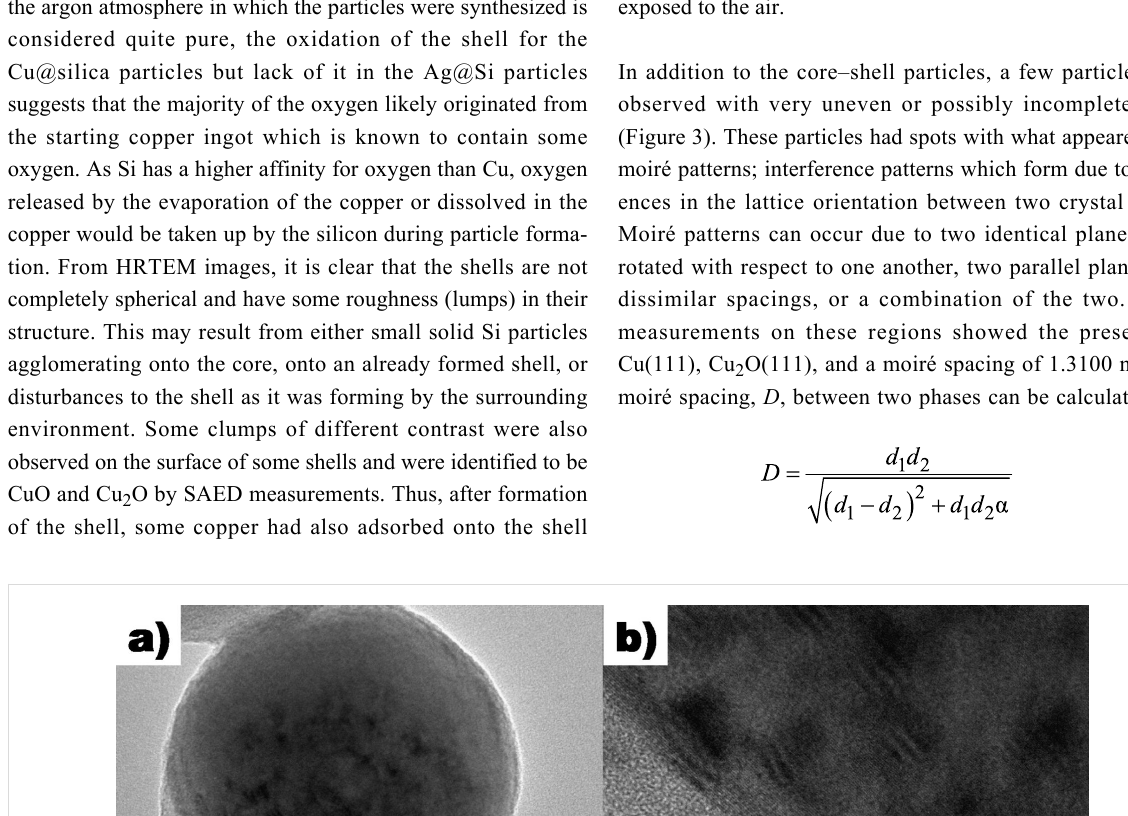
the shell is likely a mixture of amorphous Si, SiO, and SiO 2 .